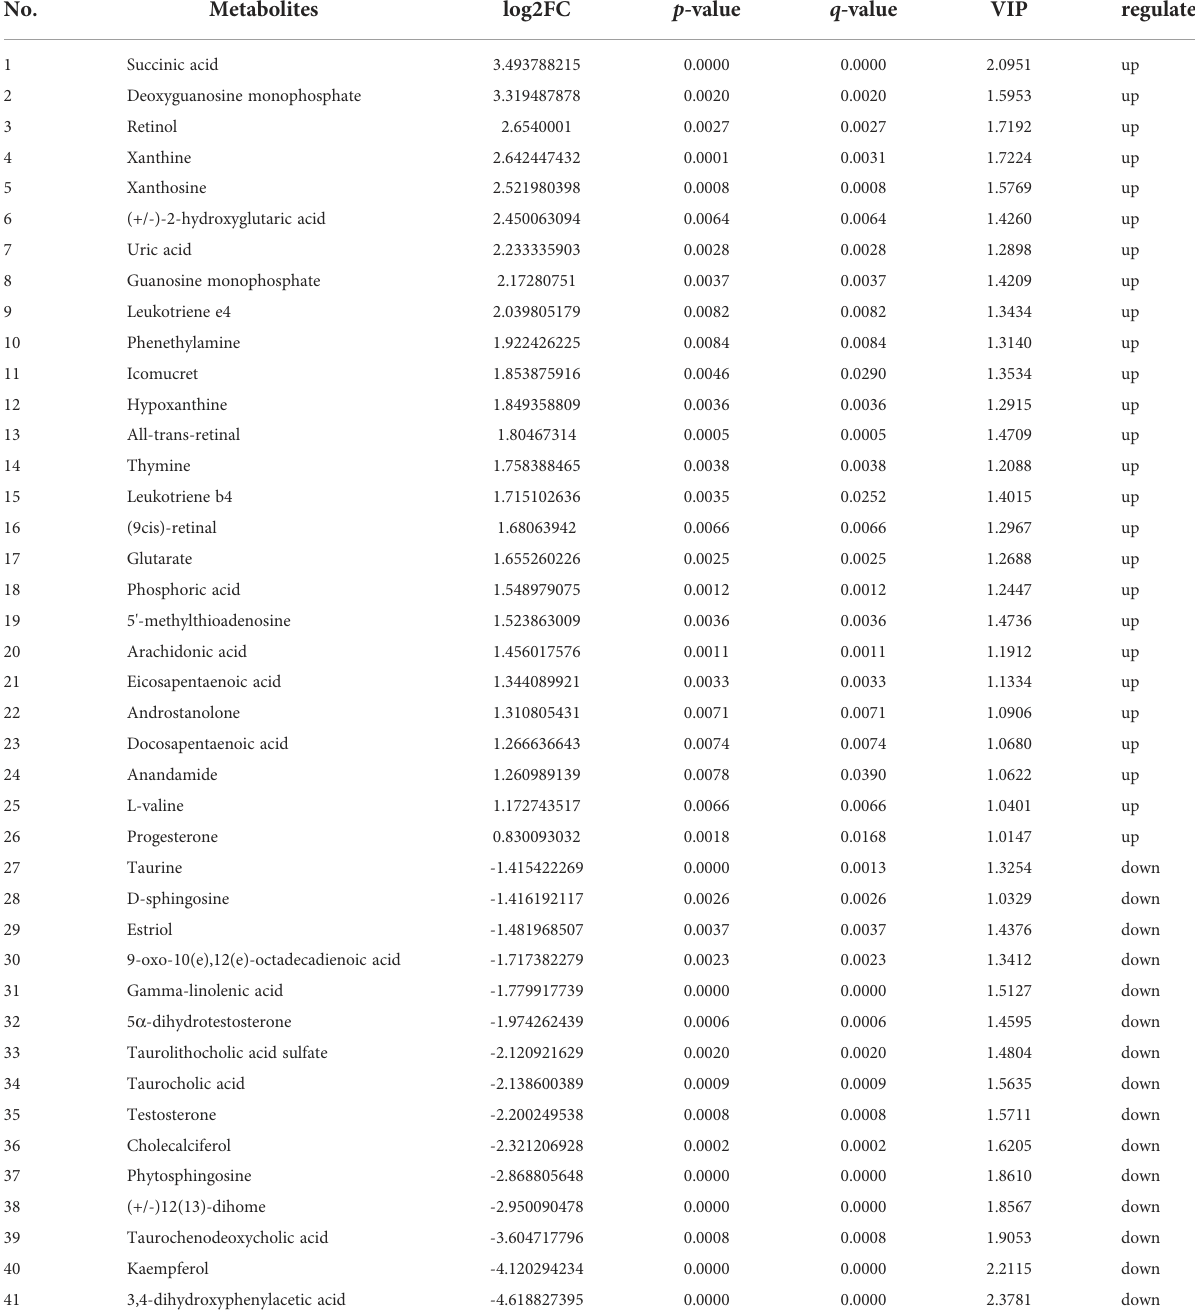
TABLE 2 41 known differential metabolites were signi fi cantly enriched in KEGG pathway enrichment analysis in positive ion mode.